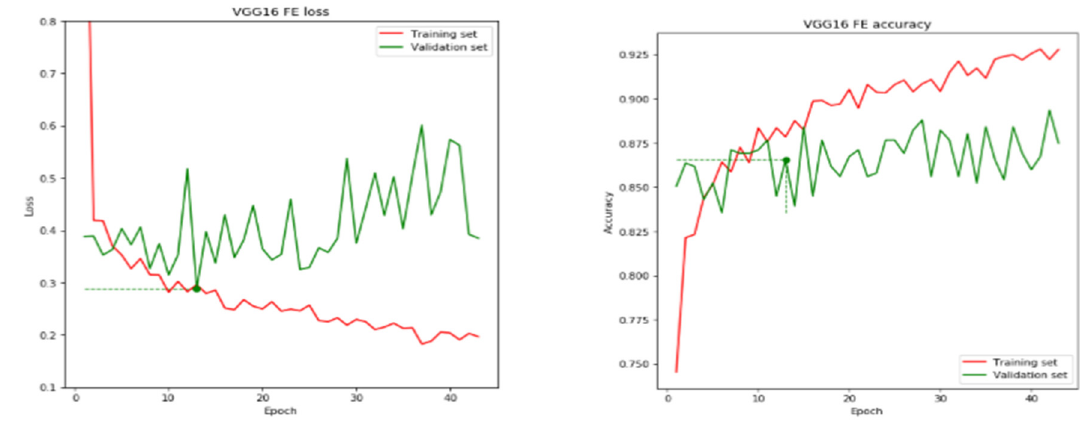
Figure 4. VGG16 Feature Extraction.